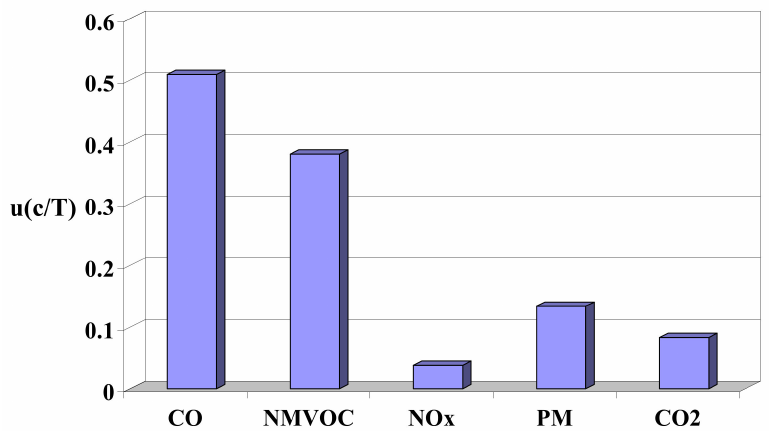
Figure 6. Share of additional annual emissions of pollutants during engine warm-up in the total annual emissions averaged over all inventory